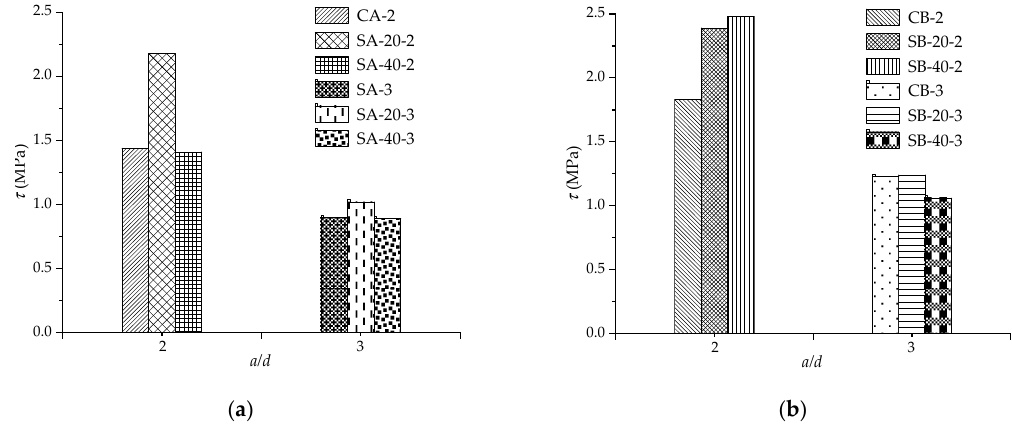
Figure 6. Ultimate shear stress of the specimens. ( a ) Type A specimens; ( b ) Type B specimens.